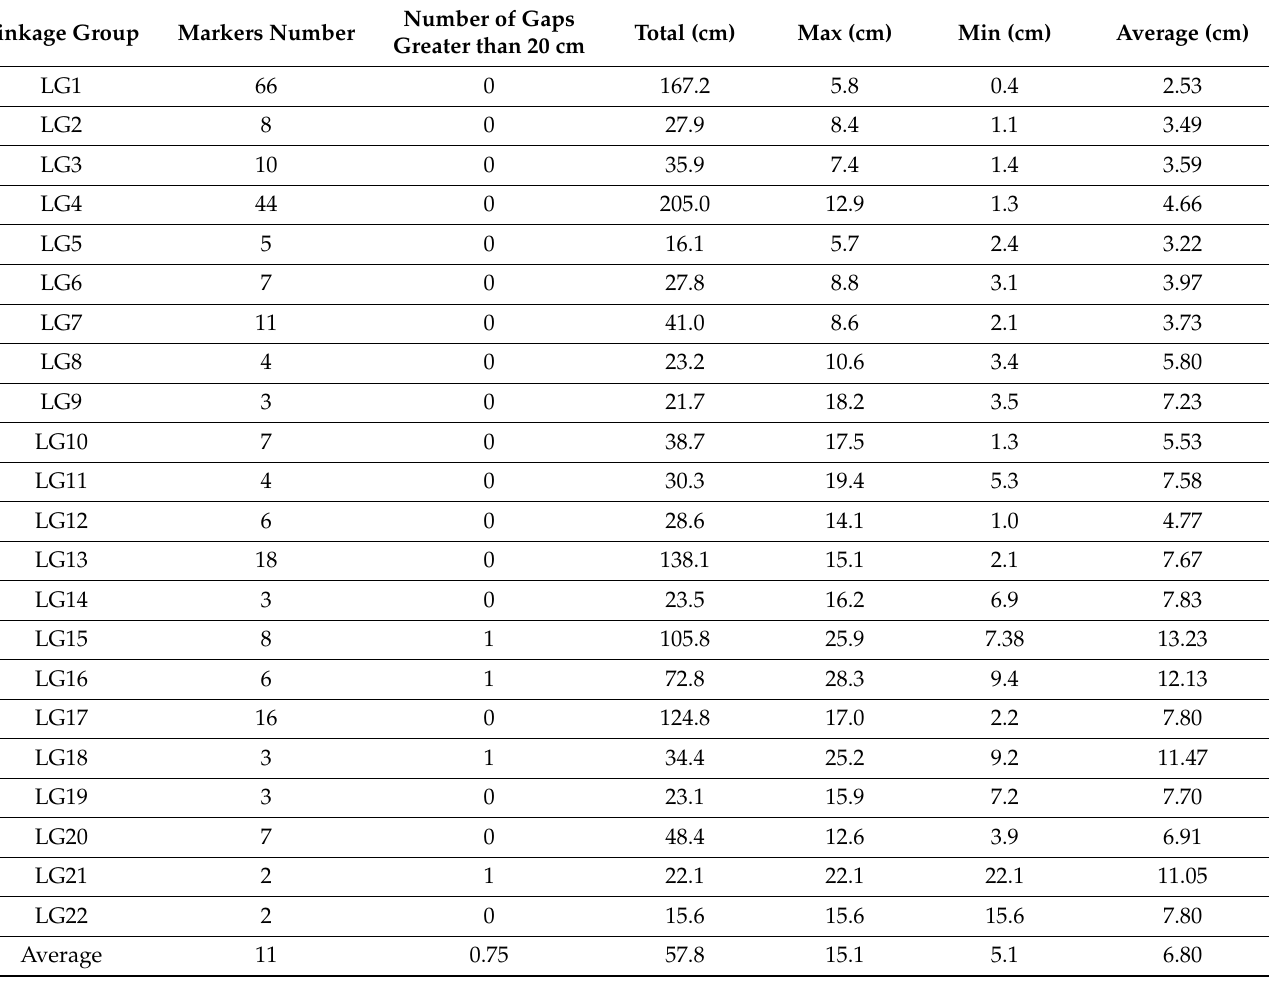
Table 2. Markers on the different linkage of the genetic maps in Largerstroemia .